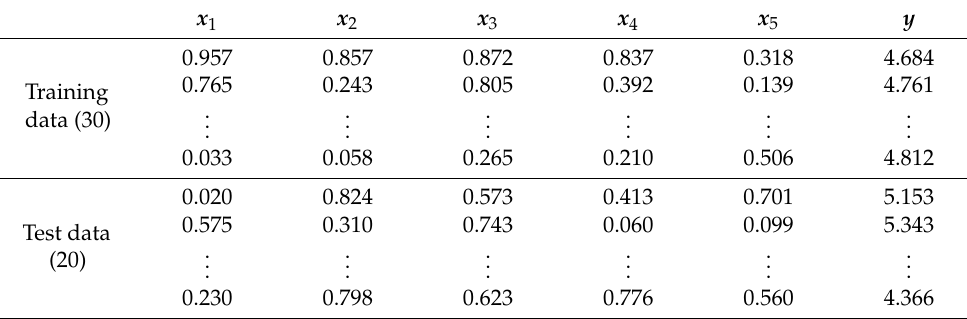
Table 2. Partial data of the original